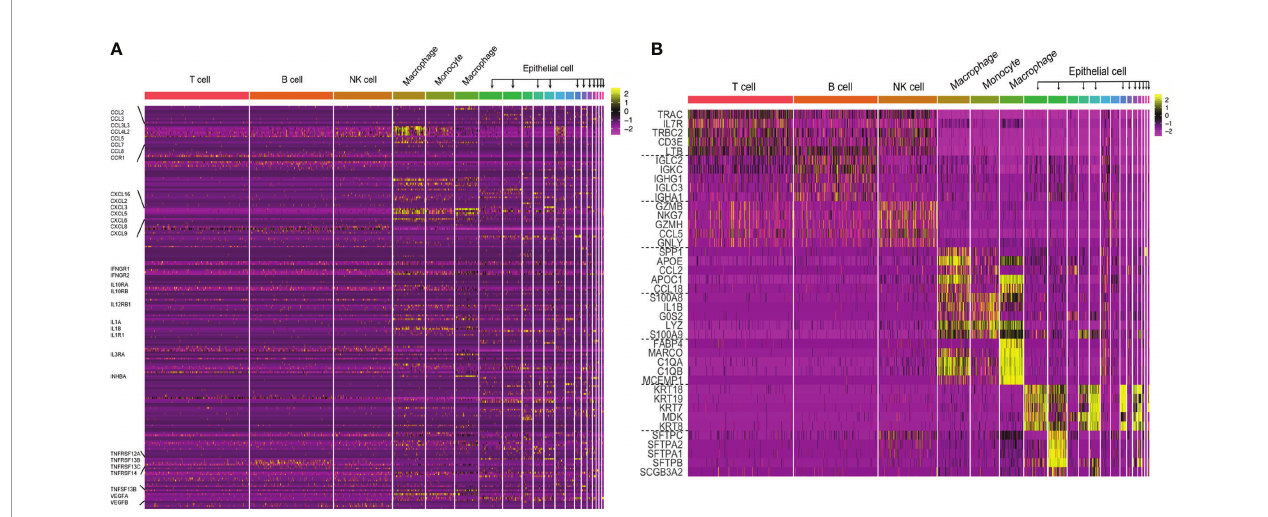
FIGURE 1 | (A) The cytokine expression across different cell types in TME of LUAD. Performed an integrative analysis using Seurat v3 in RStudio by combining the scRNAseq data from multiple datasets in LUAD (GSE97168, GSE131907, GSE99254) and plotted the expression levels of 224 cytokines across different cell types in TME. (B) Heatmap of canonical cell-type markers of different cell types in TME of LUAD. Using the same datasets and strategy employed in the above cytokine analysis, generated a heatmap of canonical cell-type markers of stromal cells in TME of